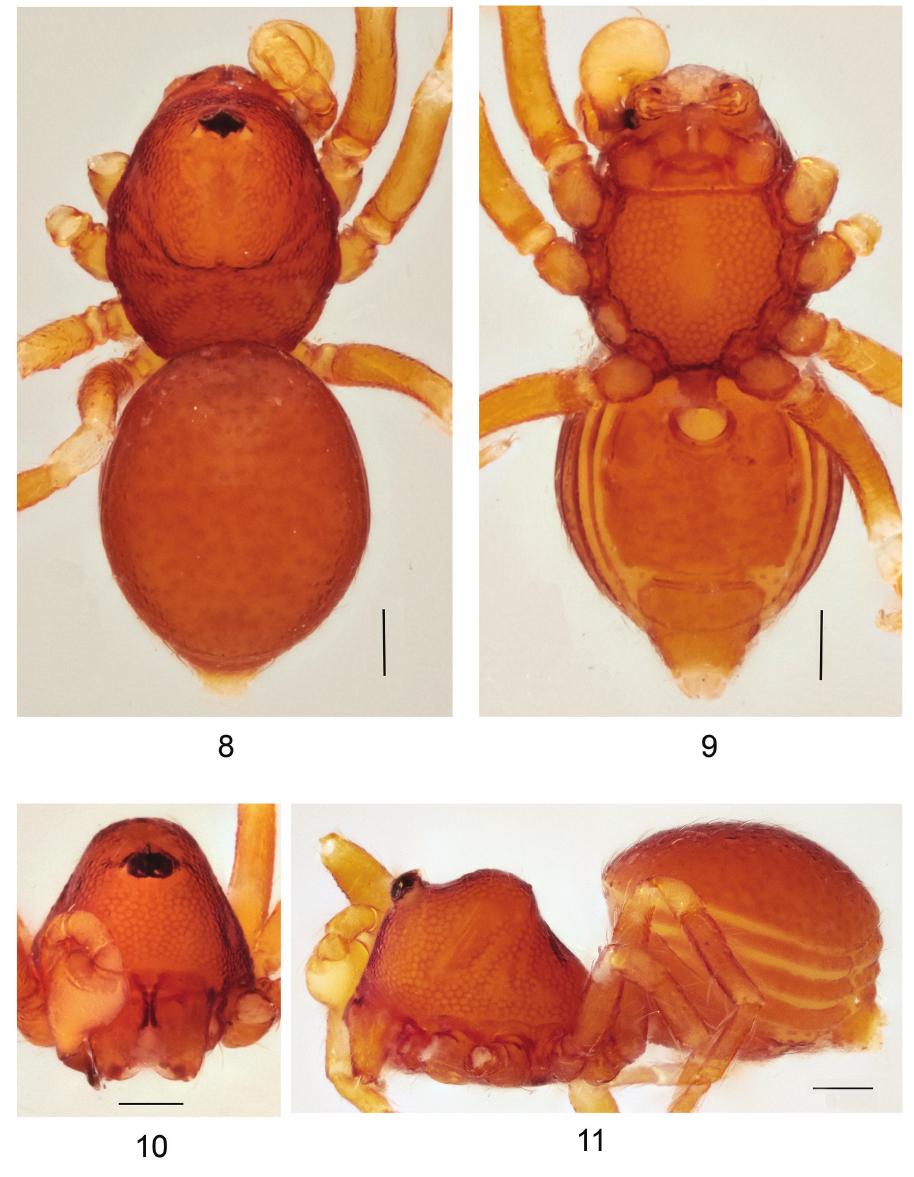
Figures 8–11. Ablemma contrita sp. n., male. 8 Habitus, dorsal view. 9 Habitus, ventral view. 10 Cara- pace, frontal view. 11 Habitus, lateral view. Scale bar: 1.0 mm. Female ( paratype ). Measurements: Total length: 0.88; carapace length: 0.42; ca- rapace width: 0.33; abdomen length: 0.46; abdomen width: 0.38; clypeus height: 0.9. Length of legs: I missing; II 0.73 (0.22, 0.11, 0.16, 0.12, 0.12); III 0.66 (0.22, 0.09, 0.15, 0.09, 0.11); IV